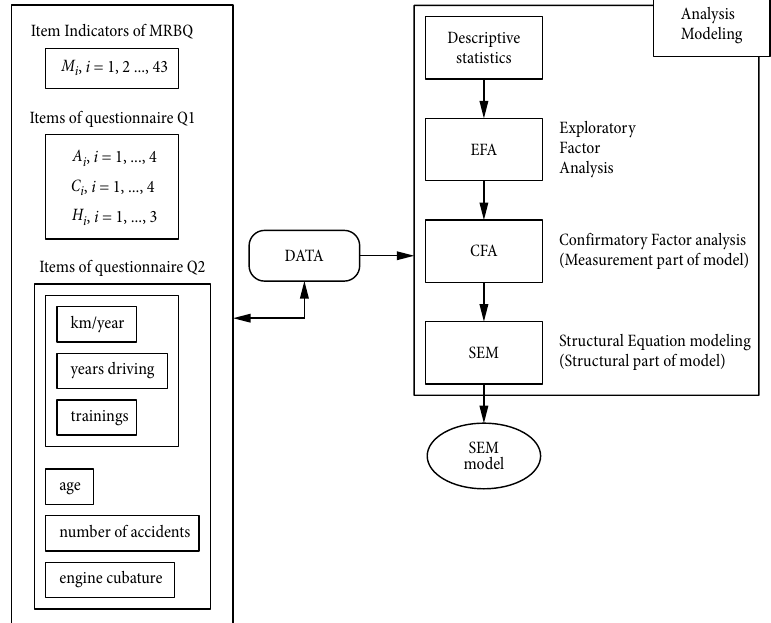
Fig. 2. The block diagram of the used